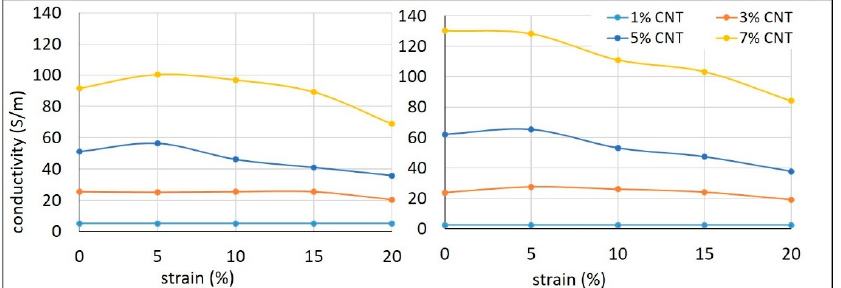
Figure 4. Effect of strain on the conductivity of silicone composites at different CNT concentrations at 6 V ( left ) and 24 V ( right ).